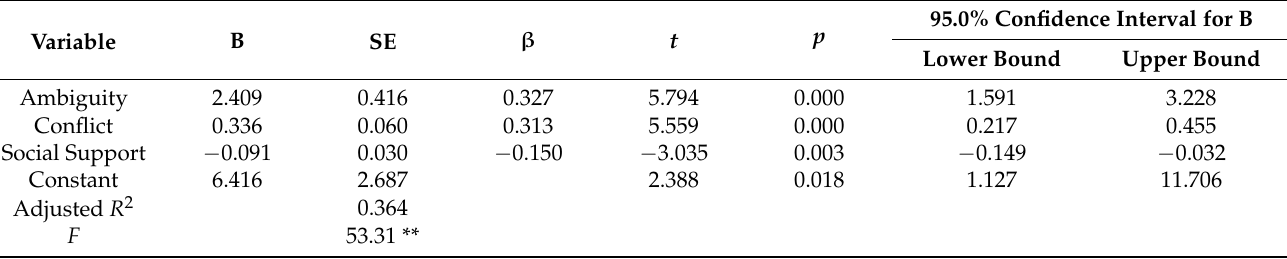
Table 4. Multiple regression analysis: predictors of